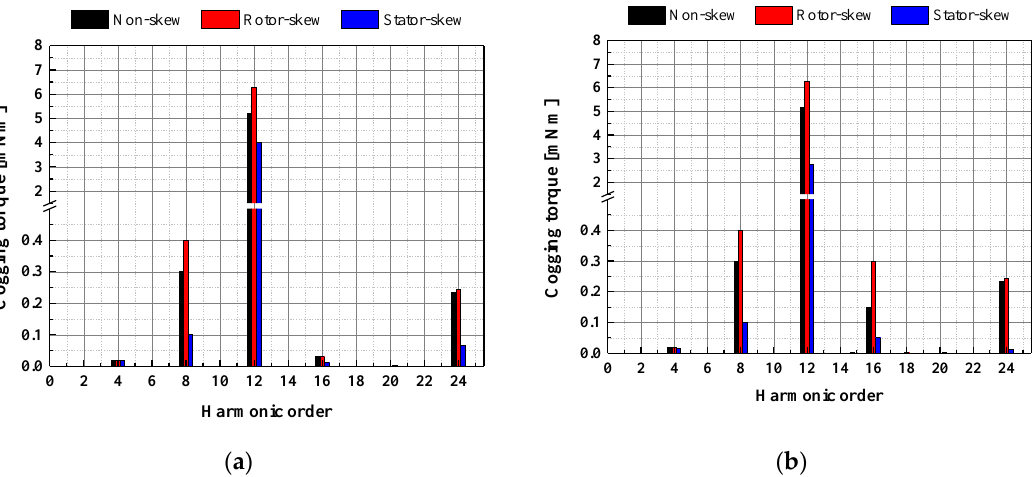
Figure 15. Harmonic order analysis considering measured B r , skew-angle, eccentricity and slot opening: ( a ) measured B r , skew-angle and eccentricity; ( b ) measured B r , skew-angle, eccentricity and slot opening.